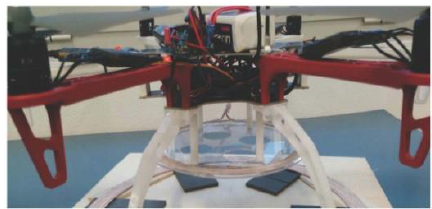
Figure 4. UAV with coil on the abdomen. Reproduced with permission from Ref. [21]; published by IEEE, 2016.